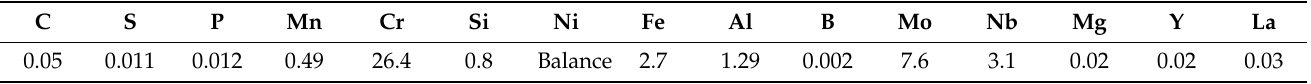
Table 2. Technological modes and test results for mechanical properties. Table 1. Chemical composition of nickel–chromium HN58MBYu alloy in